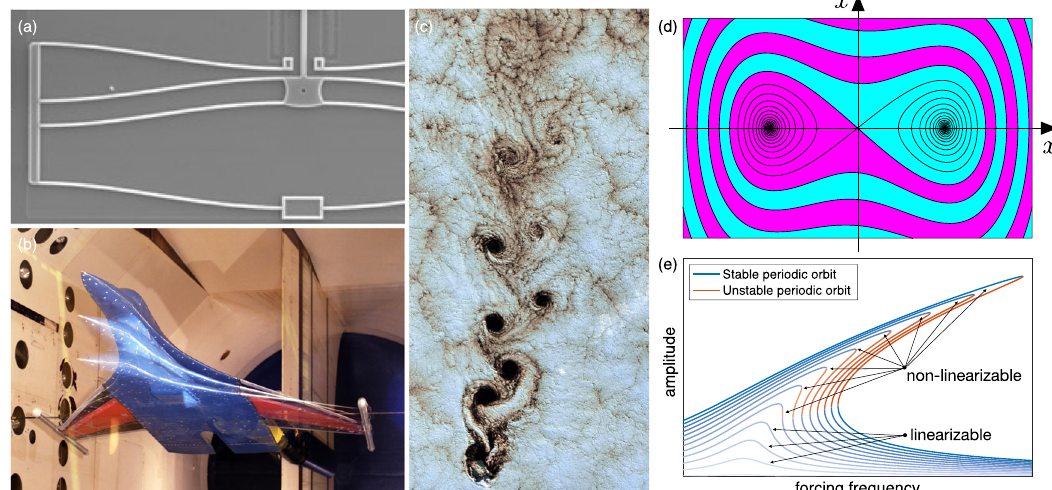
Fig. 1 Examples of non-linearizable systems. a Snap-through instability of a microelectro-mechanical (MEMS) device with three coexisting equilibria (Sandia National Laboratories). b Wind-tunnel fl utter of an airplane prototype, involving a fi xed point and coexisting limit cycles (NASA Langley Research Center). c Swirling clouds behind an island in the Paci fi c ocean, forming a vortex street with coexisting isolated hyperbolic and elliptic trajectories for the dynamical system describing fl uid particle motion (USGS/NASA). d Phase portrait of the damped, double-well Duf fi ng oscillator € x þ _ x (cid:3) x þ β x 3 ¼ 0 with β > 0, the most broadly used model for nonlinear systems with coexisting domains of attraction (colored), such as the MEMS device in plot ( a ). e Nonlinear response amplitude ( j x ð t Þj max ) in the forced-damped, single-well Duf fi ng oscillator, € x þ _ x þ x þ β x 3 ¼ f cos ω t with β > 0, under variations of the forcing frequency ω and forcing amplitude f . Coexisting stable and unstable periodic responses show non-linearizable dynamics conclusively for this classic